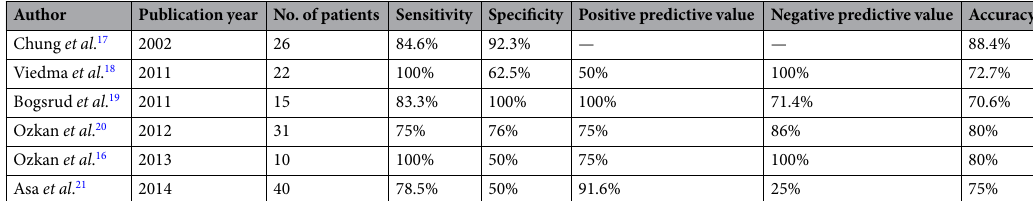
Table 6. Diagnostic efficacies of 18 F-FDG PET/CT in patients with DTC and elevated serum TgAb in other